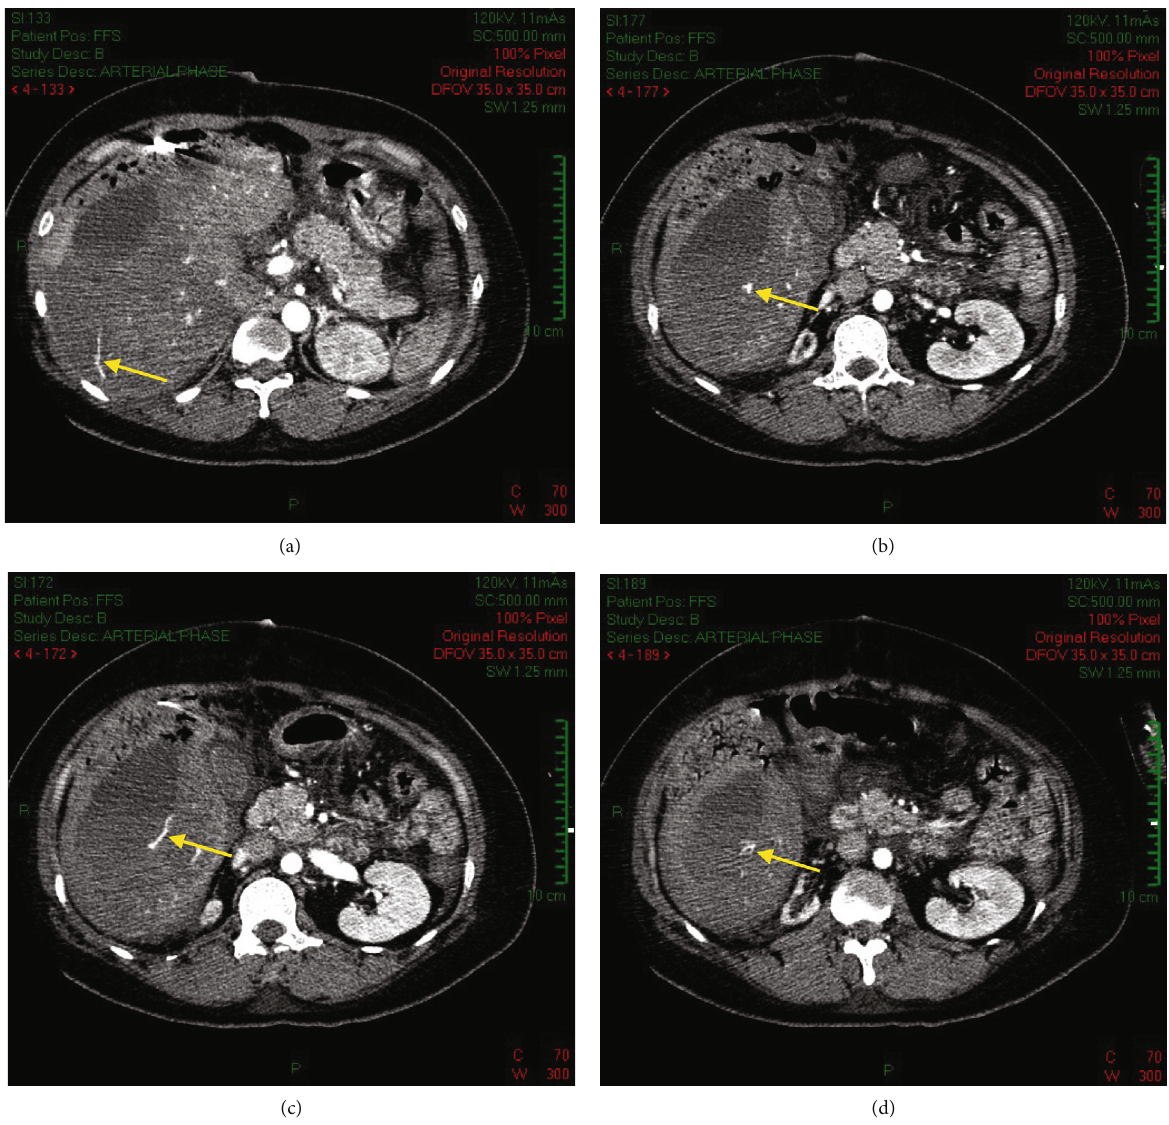
Figure 4: Subhepatic hematoma and subscapular active bleeding on CT scan at ED. (a, c) Active bleeding signs (yellow arrow) and (b, d) other extravascular contrast (yellow arrow). CT: computed tomography; ED: emergency